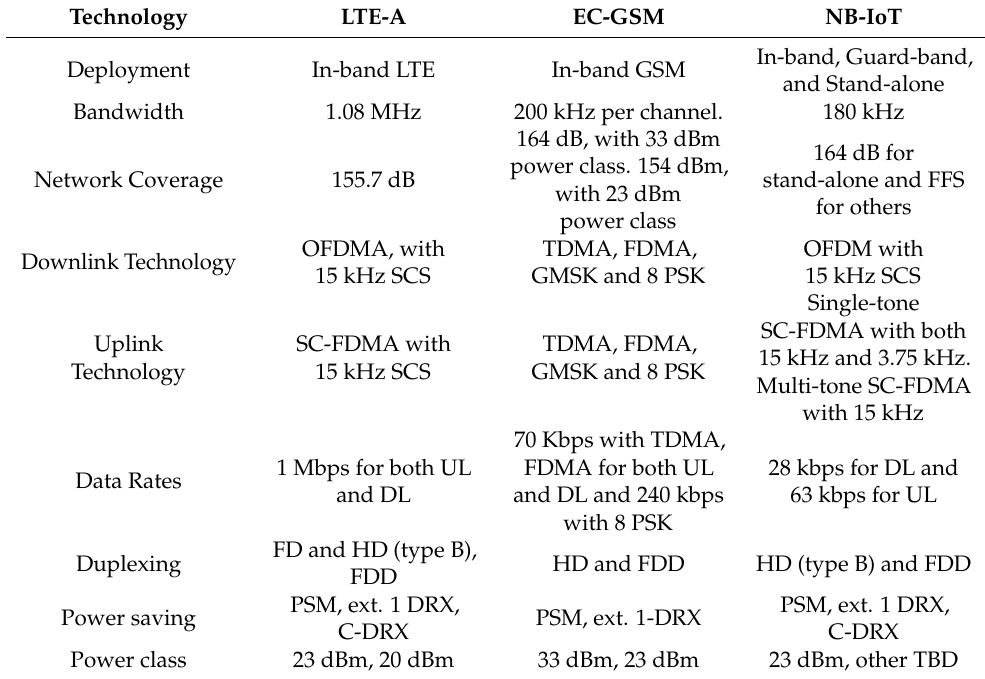
Table 1. Technical specification of LPWA network